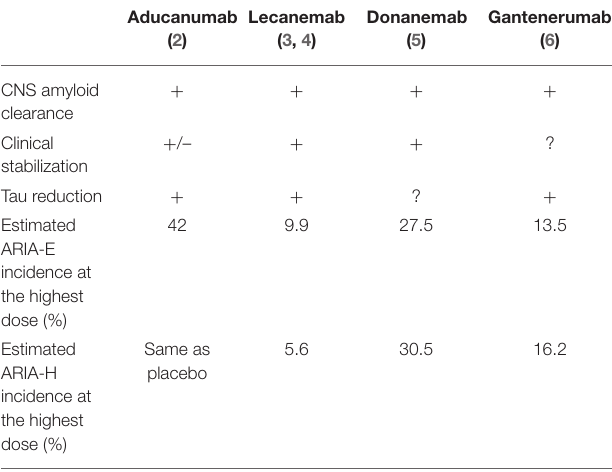
TABLE 1 | Safety and efficacy of second-generation anti-amyloid monoclonal